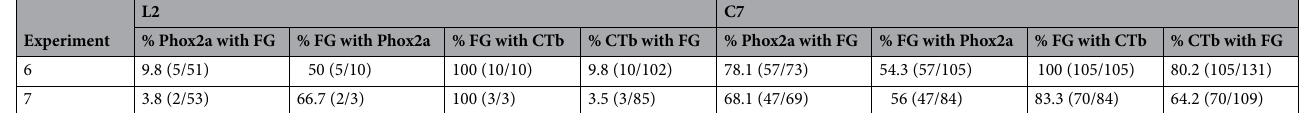
Table 3. Quantitative data for retrograde tracing experiments involving injection of Fluorogold (FG) into the thalamus. Cells show percentages, with the actual numbers in